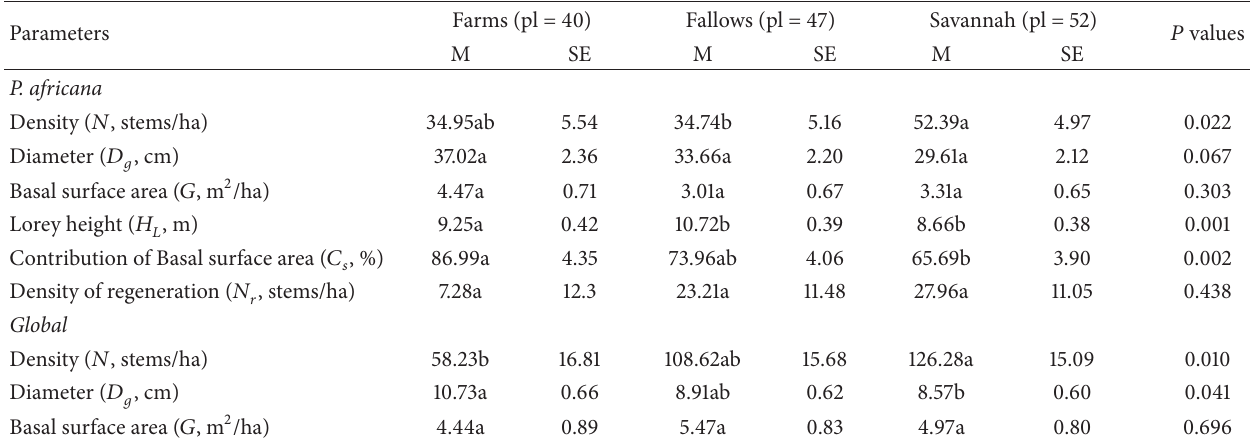
Table 4: Dendrometric characterization of P. africana according to vegetations types.